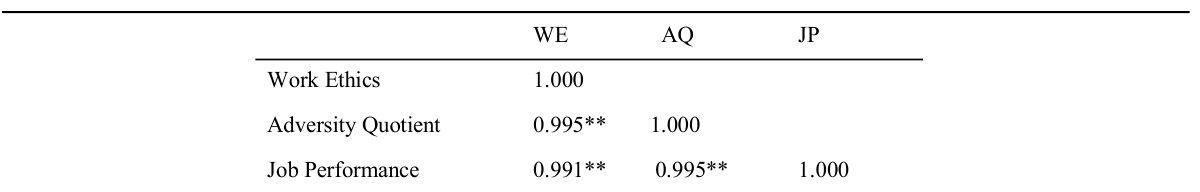
Table 3: Correlations